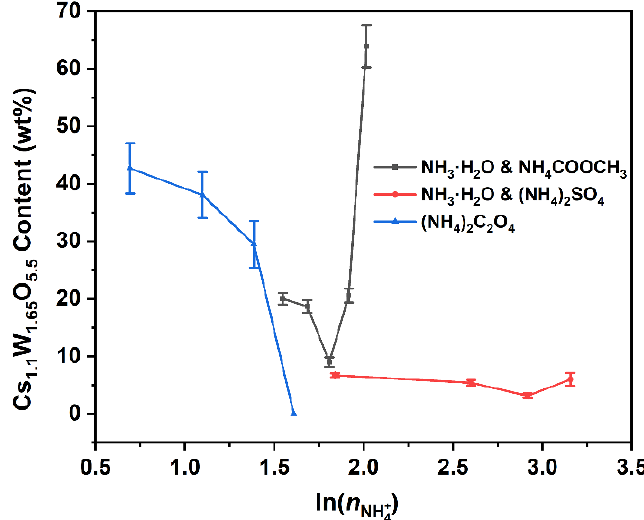
Figure 9. Contents of Cs 1.1 W 1.65 O 5.5 versus various ammonium sources in the system of WO 3 , CsCl, CH 3 CH 2 CHO and NH 3 ·H 2 O and NH 4 COOCH 3 ; NH 3 ·H 2 O and (NH 4 ) 2 SO 4 ; (NH 4 ) 2 C 2 O 4 . Note: Cs 1.1 W 1.65 O 5.5 Content Cs W O Content = (cid:2887)(cid:2929) (cid:3117) . (cid:3117) (cid:2907) (cid:3117) . (cid:3122)(cid:3121) (cid:2899) (cid:3121) . (cid:3121) (cid:2869) . (cid:2869) (cid:2869) . (cid:2874)(cid:2873) (cid:2873) . (cid:2873) (cid:2907)(cid:2899) (cid:3119) (cid:2878) (cid:2887)(cid:2929) (cid:3116) . (cid:3119) (cid:2907)(cid:2899) (cid:3119) (cid:2878) (cid:2887)(cid:2929) (cid:3117) . (cid:3117) (cid:2907) (cid:3117) . (cid:3122)(cid:3121) (cid:2899) (cid:3121) . (cid:3121)